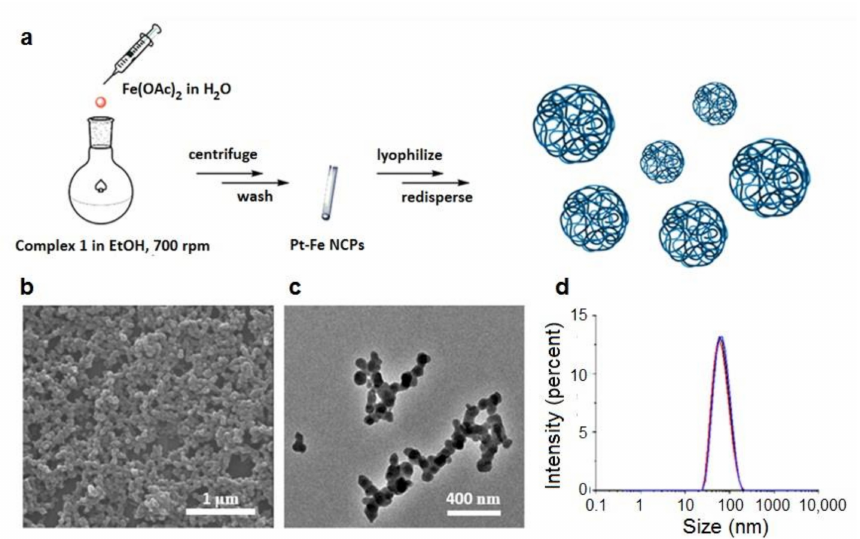
Figure 2. Pt-Fe NCPs: ( a ) Schematic illustration of the synthesis; ( b ) Representative SEM and ( c ) TEM images; ( d ) Representative size distribution obtained by DLS in